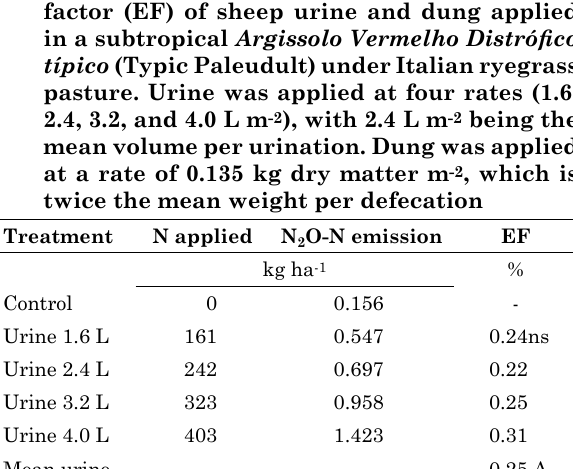
table 2. Cumulative emission of N 2 o-N in the whole measurement period (39 days) and emission factor (ef) of sheep urine and dung applied in a subtropical Argissolo Vermelho Distrófico típico (typic Paleudult) under italian ryegrass